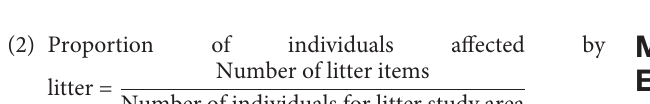
(2) Proportion of individuals affected